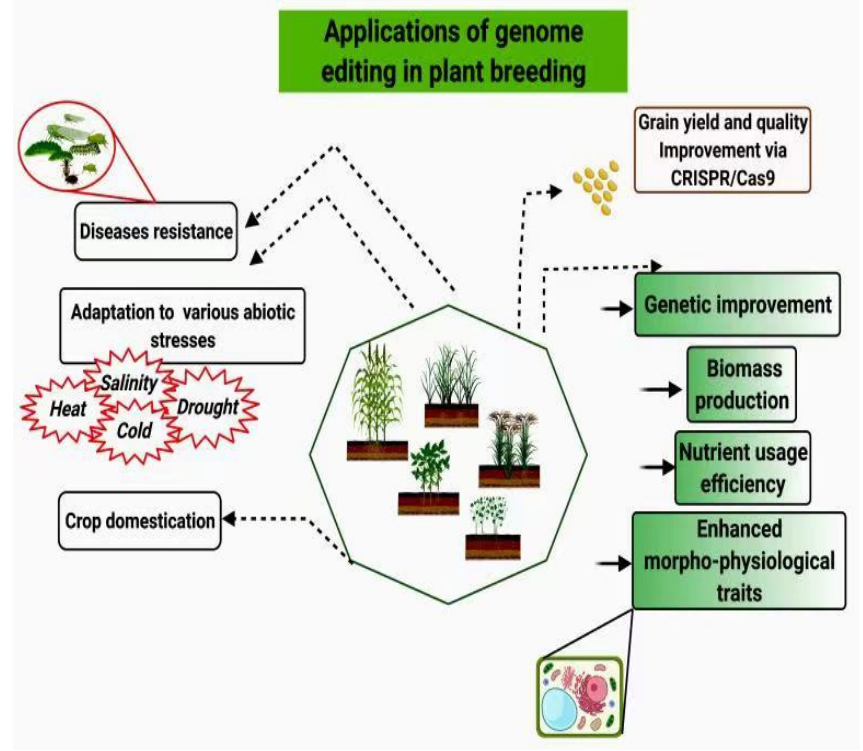
Figure 1. Application of genome editing in crops improvement. CRISPR/Cas9 is used for genetic improvement, increasing nutrients use efficiency, biomass production, and increasing disease re- sistance.